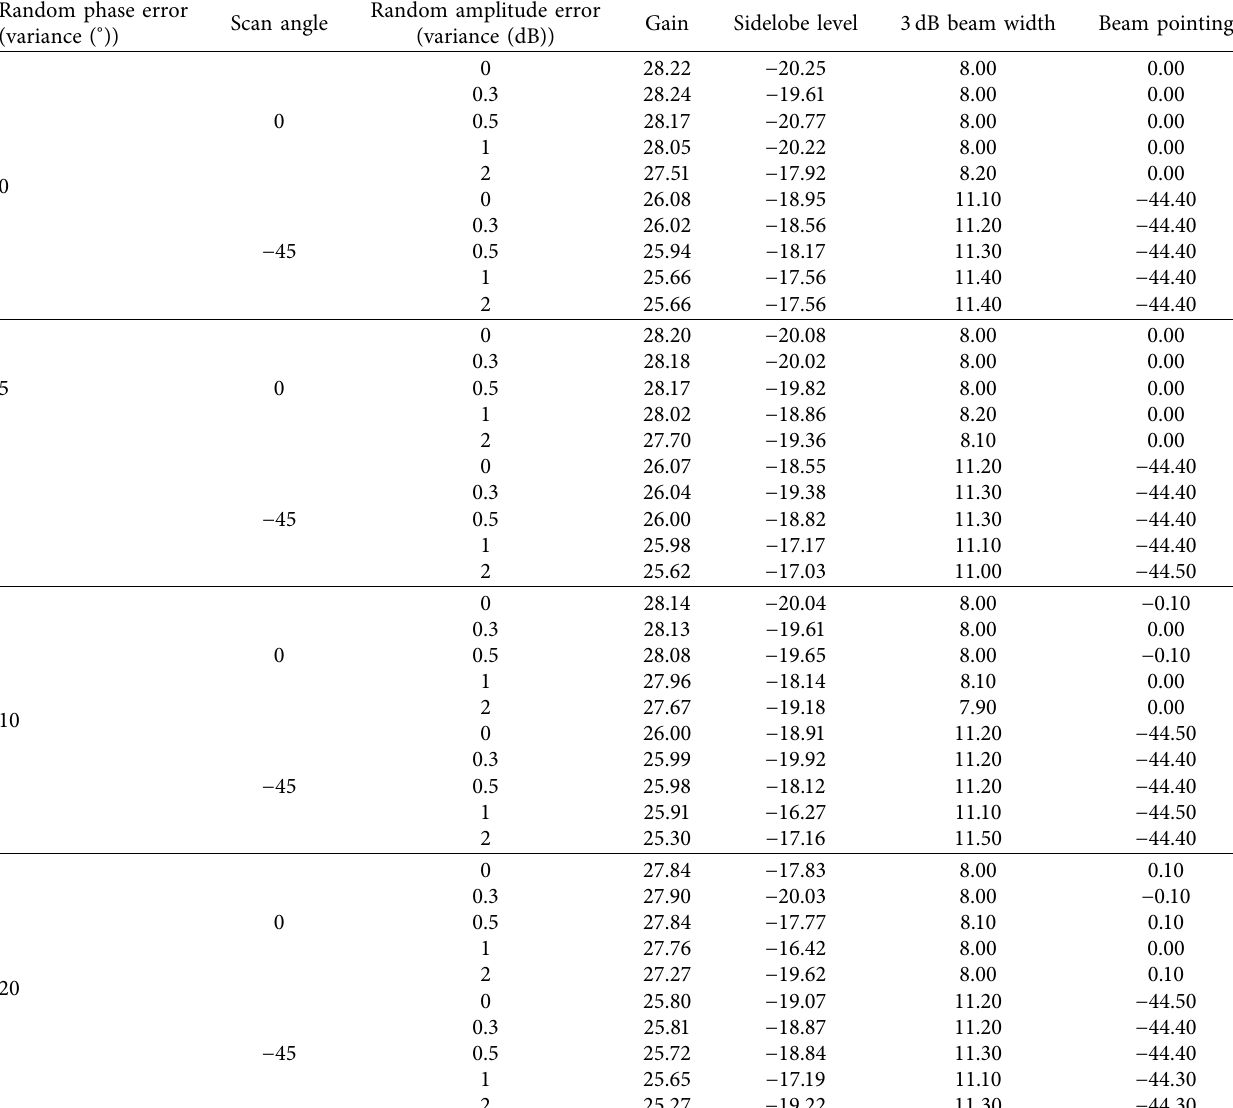
Table 1: Technical index statistics under the condition of random amplitude and phase